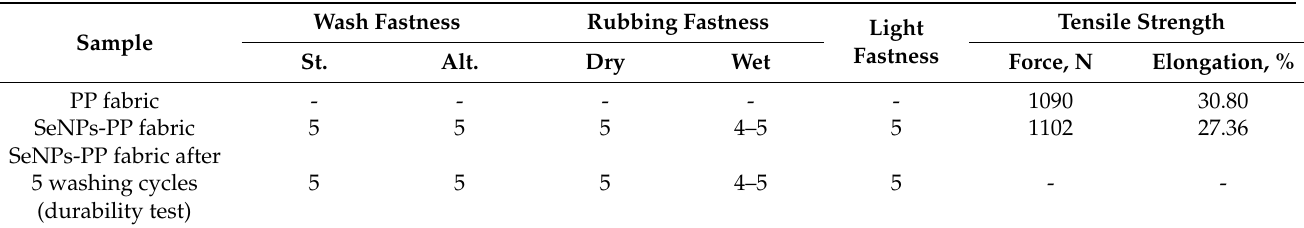
Table 2. Properties of the PP and SeNPs-PP fabrics under optimum conditions.